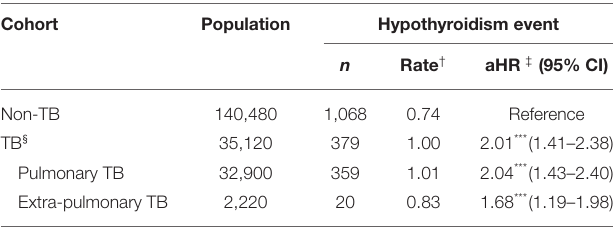
TABLE 5 | Adjusted hazard ratios of developing hypothyroidism in TB cohort (purpose